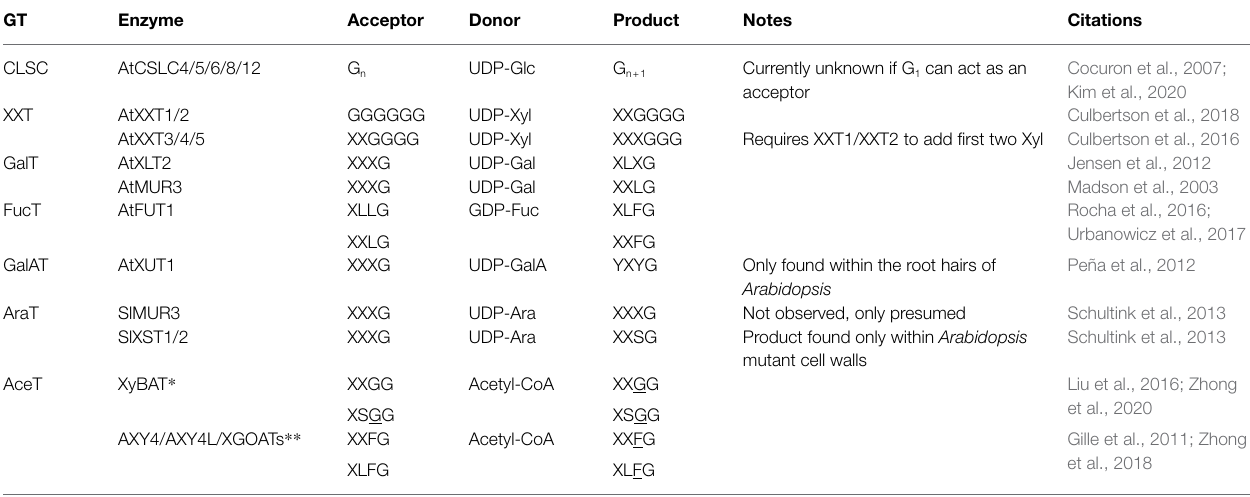
TABLE 2 | Current understanding of substrate specificity of XyG synthesizing